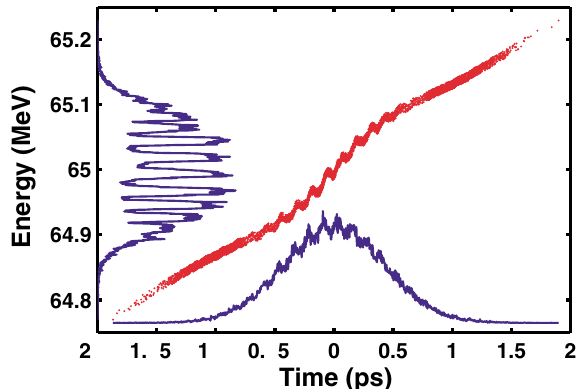
FIG. 5. (Color) Illustration of an electron bunch longitudinal phase space produced by a simulation of a zero-phasing mea- surement. The horizontal axis is time (ps); the vertical axis is energy (MeV). The space charge wake induces variations of the energy along the chirped bunch leading to deeply modu- lated energy spectra. The red curve is the distribution of electrons in time-energy phase space. The zero-phasing method measures only the projection on the energy axis whereas there is only a small modulation in the time